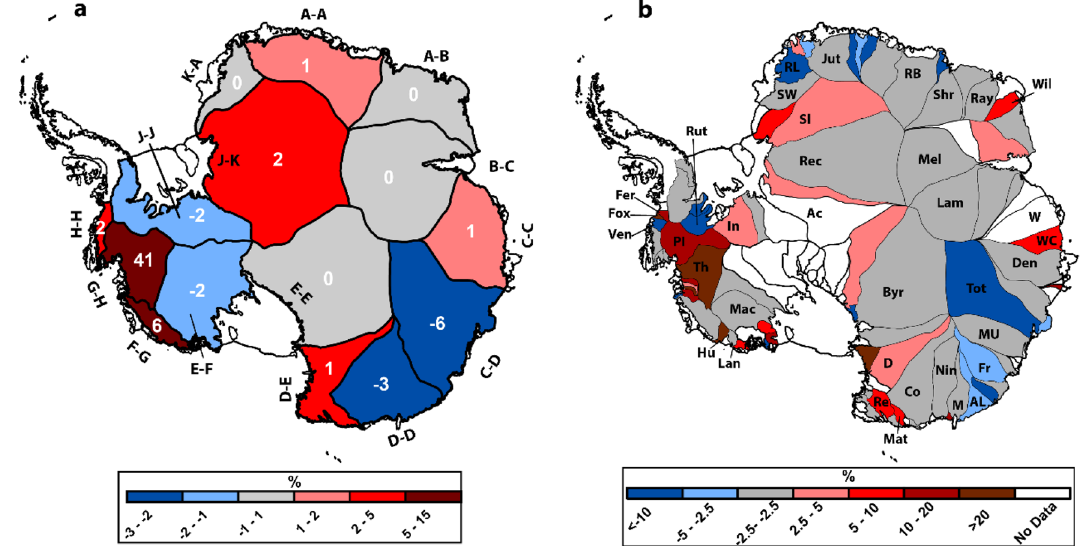
Figure 2. ( a ) Percentage change in ice discharge between 1999–2005 and 2018 for each IMBIE drainge basin 12 , the white numbers are the change in Gt year −1 . ( b ) Percentage change in ice discharge between 1999–2005 and 2018 for each individual catchment 3 : Ferrigno (Fer), Fox (Fox), Vennable (Ven), Pine Island (PI), Thwaites (Th), Hull (Hu), Land (Lan), MacAyeal (Mac), Byrd (Byr), David (D), Rennick (Re), Matusevich (Mat), Cook (Co), Ninnis (Nin), Mertz (M), Adelie Land (AL), Frost (Fr), Moscow University (MU), Totten (Tot), Denman (Den), Wilhelm II Coast (WC) West (W), Lambert (Lam), Mellor (Mel), Wilma (Wil) Rayner (Ray), Shr (Shirase), Roi Baudouin (RB), Jutulstraumen (Jut), Riiser-Larsen (RL), Stancomb-Wills (SW), Slessor (Sl), Reocvery (Rec), Academy (Ac), Insititue